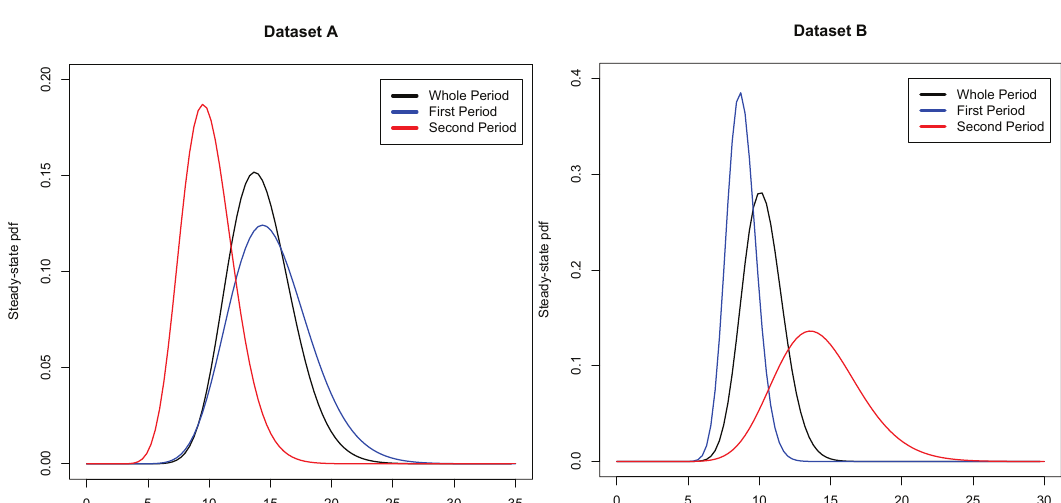
Figure 3. CIR steady-state densities for Datasets A (on the left ) and B (on the right ) evaluated by using θ given in Table 3 for the whole period: 1 July 1997–31 March 2015 and by using the parameters given in Table 4 for the sub-intervals identified by the Chow